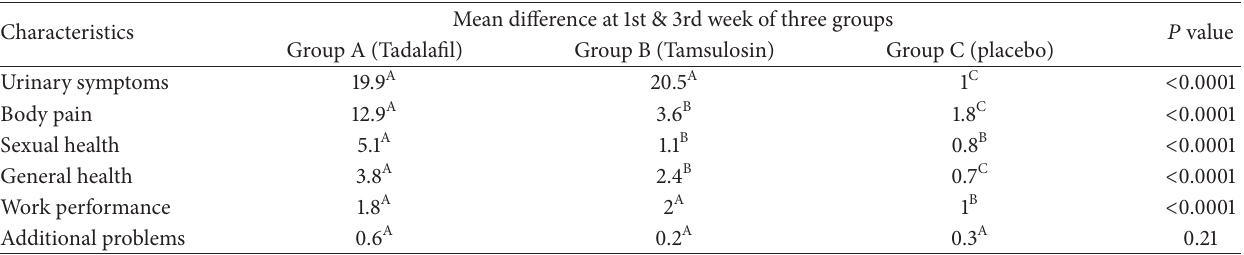
Table 3: Comparison of mean difference of ureteral stent symptom score at 1st week and 3rd week in three groups.